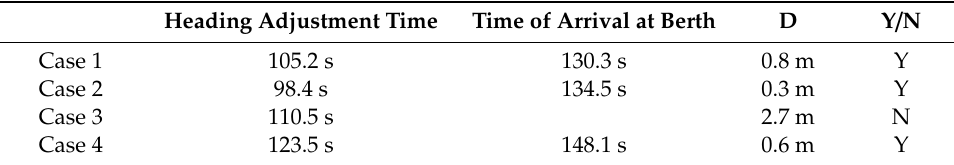
Table 6. Analysis of the results of the experiment of ship automatic berthing.